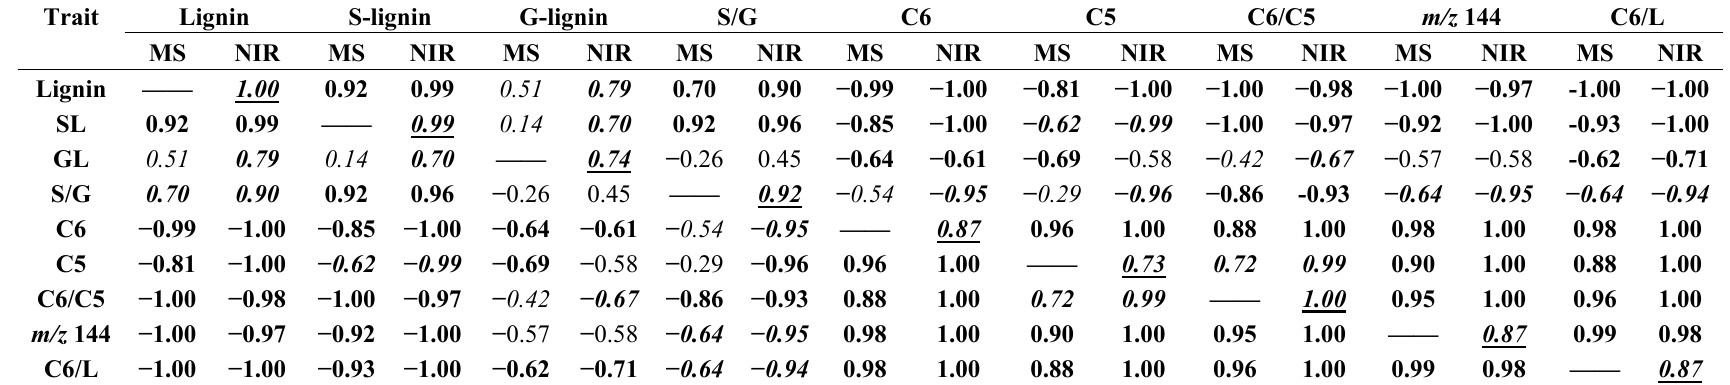
Table 3. Pair-wise comparisons of genotypic correlations between chemical traits for both NIR and pyMBMS. Trait